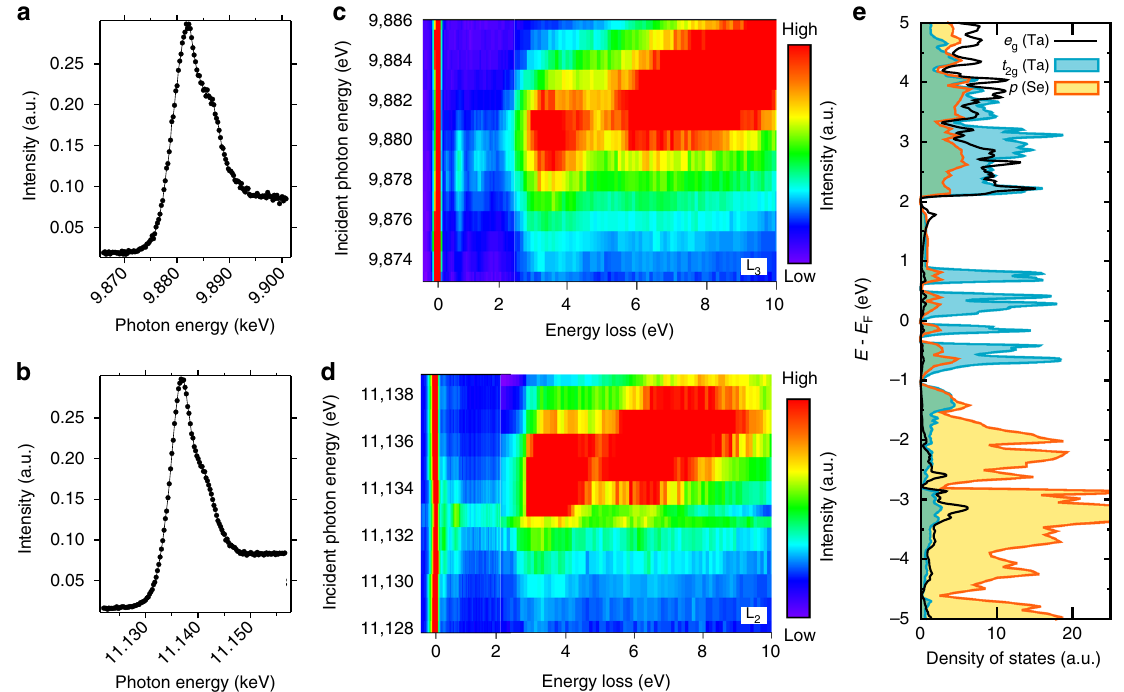
Fig. 2 XAS and RIXS spectra and the projected DOS. a , b High-resolution Ta L 3 -edge a and L 2 -edge b XAS spectra of GaTa 4 Se 8 measured in the partial yield mode. c , d High-resolution Ta L 3 -edge c and L 2 -edge d RIXS spectra as functions of the incident photon energy ( E i ) and energy loss. Both spectra show the broad excitation over the three − 7 eV energy loss. Below 2 eV, the three narrow peaks are clearly visible in the L 3 -edge RIXS spectra. But the third peak at 1.3 eV is missing in the L 2 -edge RIXS spectra. e The calculated DOS projected onto Ta- e g ( black ), Ta- t 2g ( cyan ) and Se- p ( yellow ) orbitals. In the region of E F